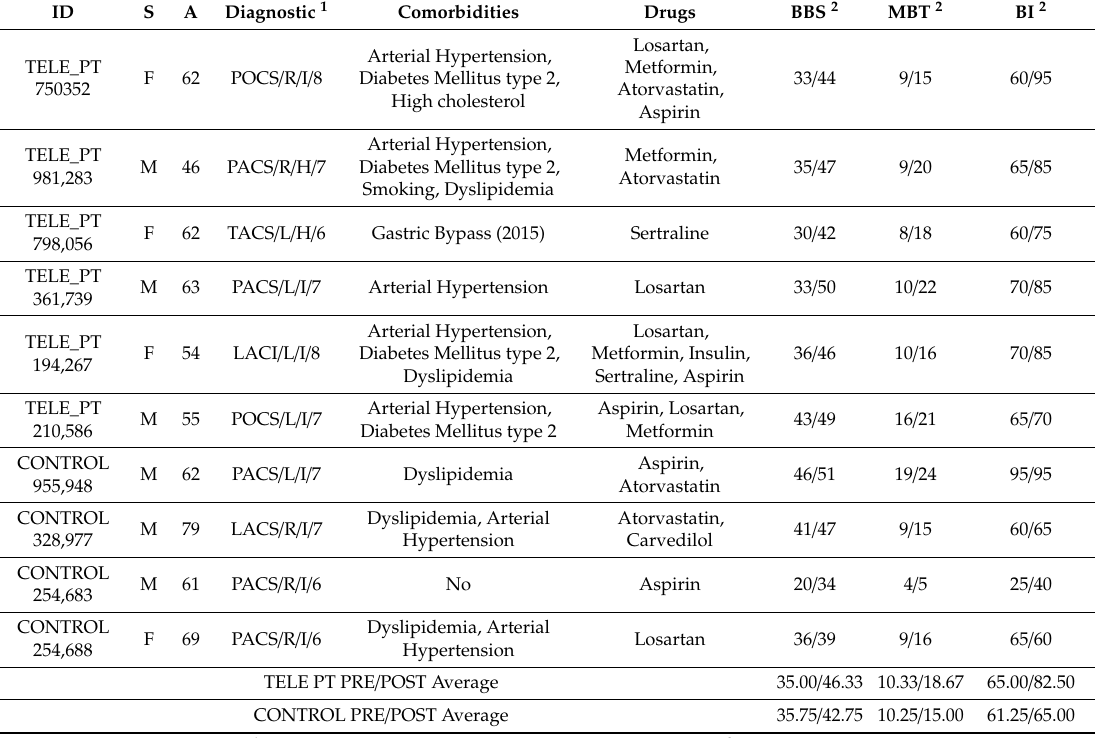
Table 1. Participants’ description. Summary of participants description and detailed scale values.